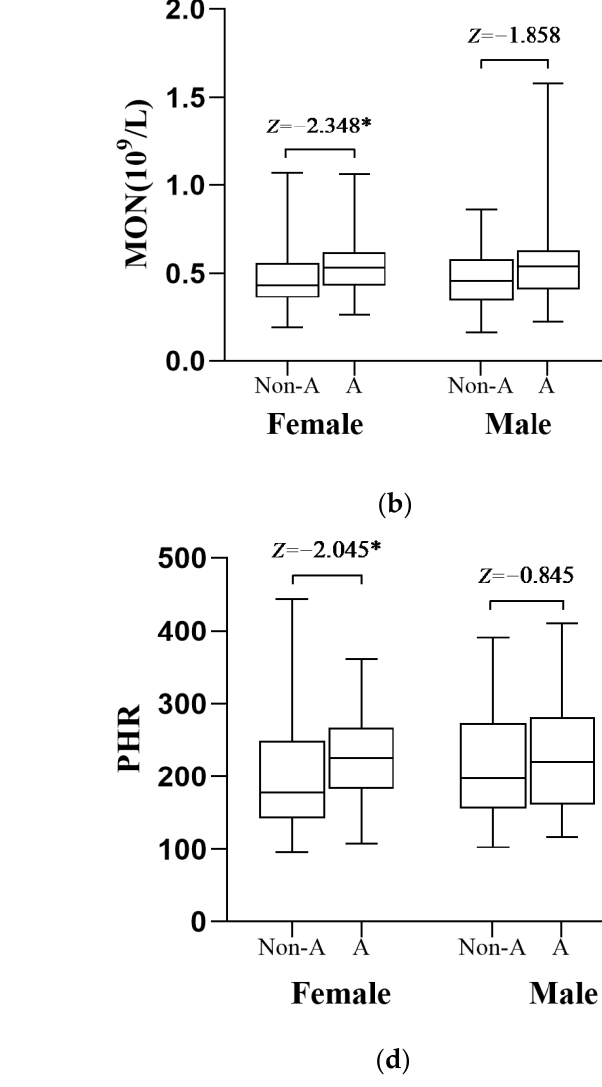
Figure 1. The values of MON, PLT, PHR and MHR in the aggressive group and non-aggressive group, separated by sex. The PLT was higher in the aggressive male group (( a ), Z = −1.758 , p = 0.015). Female schizophrenia patients with aggressive behavior had a higher level of MON ((b), Z =−2.348, p = 0.019). Higher values of the PHR (( d ), Z =−2.045, p = 0.05) and MHR (( c ), Z =−1.961, p = 0.041) were observed in the aggressive female patients. Non-A, non-aggressive group; A, aggressive group. PLT: platelets; MON: monocytes; PHR: platelet/high-density lipoprotein ratio; MHR: monocyte/high-density lipoprotein ratio. * p < 0.05 .